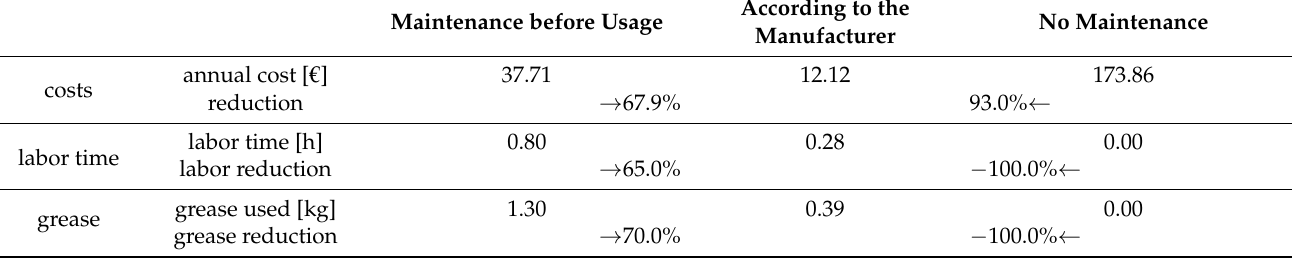
Table 6. Reduction of costs, labor time and grease for the manure tank from the extreme scenarios to when maintenance is carried out as specified by the